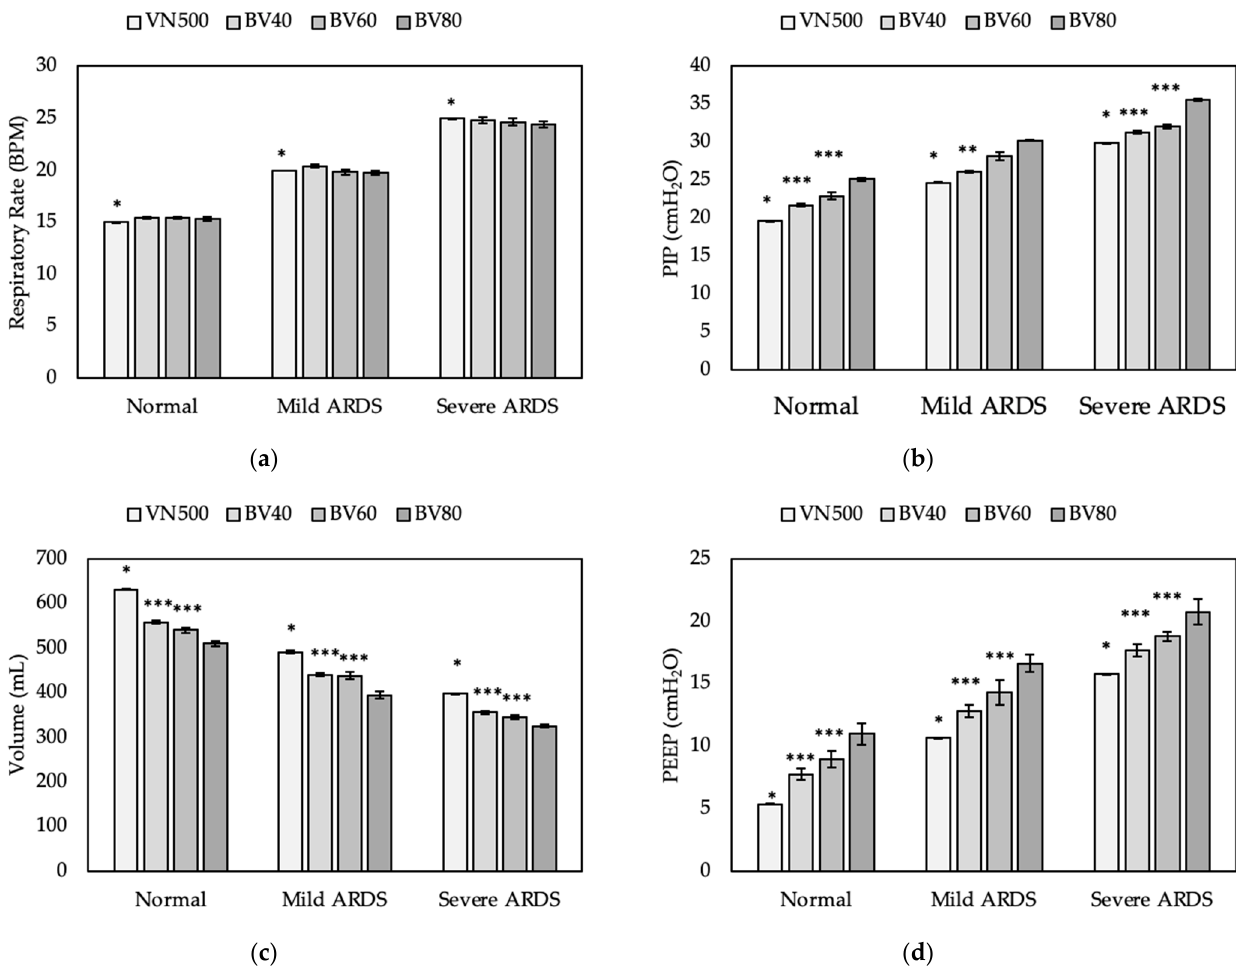
Figure 6. Outcomes of comparison test between the BubbleVent at different bias flow rates and Draeger VN500. Graph ( a ) compares the RR of the 4 ventilators, graph ( b ) compares the measured PIP outcomes, graph ( c ) compares the volume delivery outcomes, and graph ( d ) compares the mea- sured PEEP values. A “*” indicates significantly different than all three ventilators; a “**” indicates significantly different than BV60 and BV80; a “***” indicates significantly different than BV80 only. All bars are mean ±